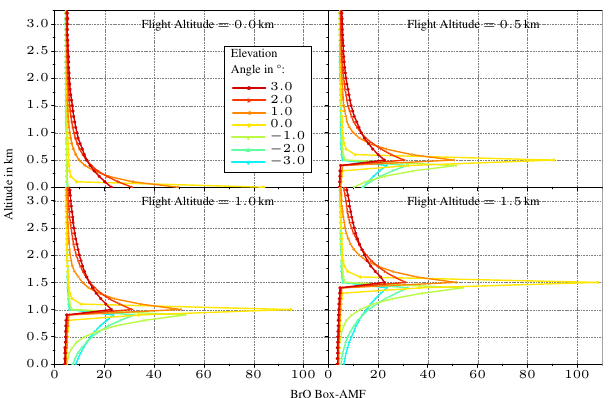
Figure 15. BrO box AMFs calculated for the different viewing di- rections of HAIDI’s forward-looking telescope.